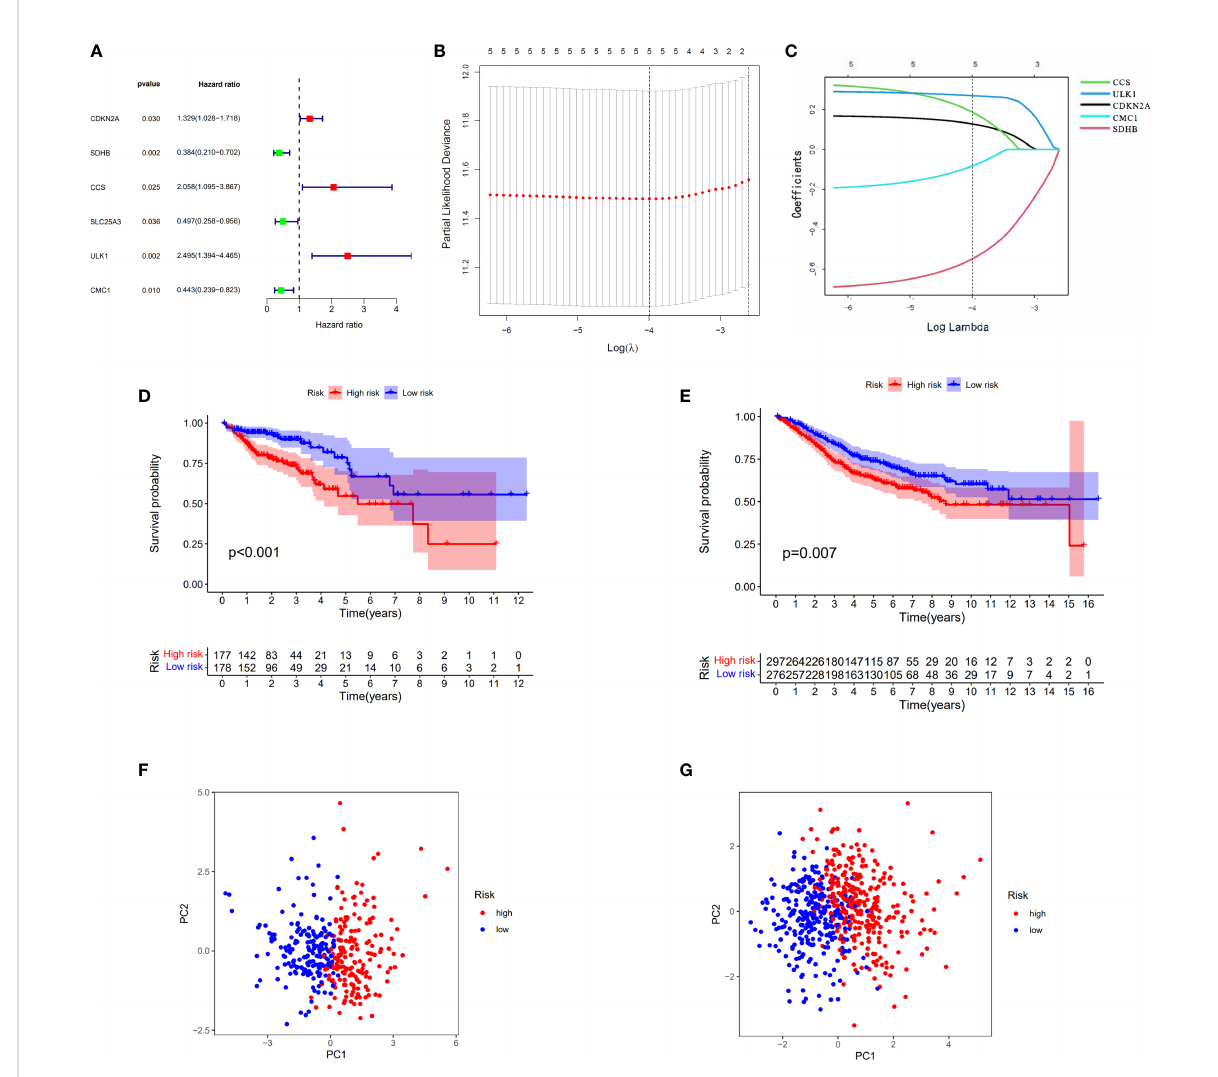
FIGURE 4 Construction of the risk score model for COAD. (A) Univariate Cox analysis for curoptosis-related DEGs. (B, C) The selection of curoptosis- related DEGs performed by LASSO regression analysis. (D) Survival analysis of the risk score model in TCGA. (E) Survival analysis of the risk score model in GEO. (F) PCA plot of the risk score model in TCGA. (G) PCA plot of the risk score model in